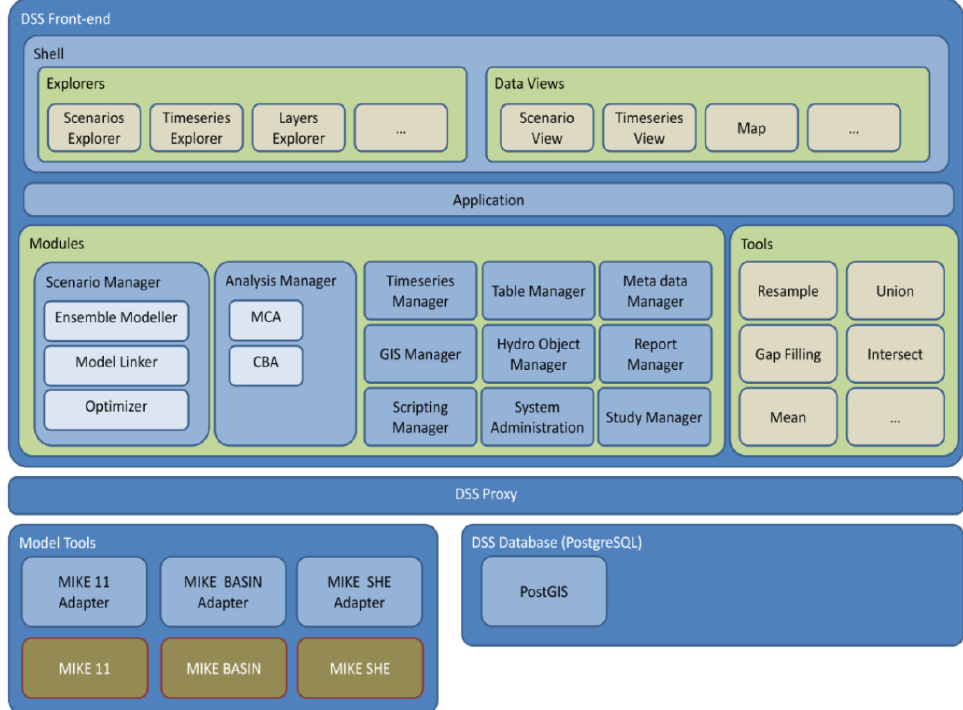
Figure 3. A simplified block diagram showing the relationships between DSS components